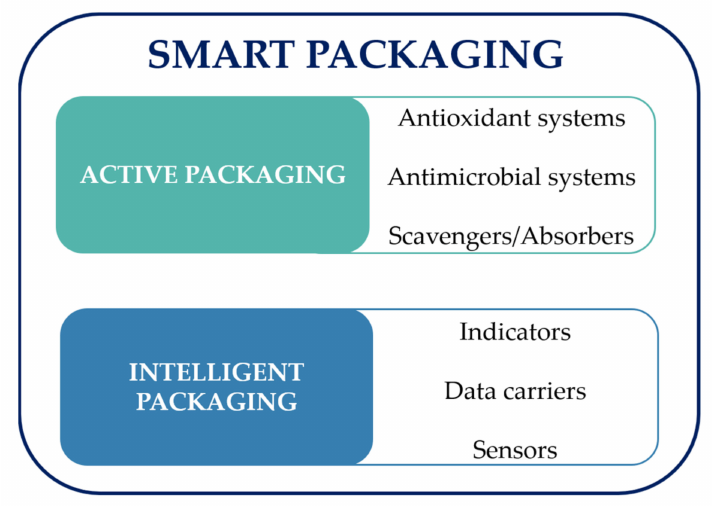
Figure 1. Schematic illustration of active, intelligent, and smart